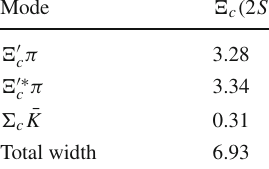
Table 3 Strong decays of the